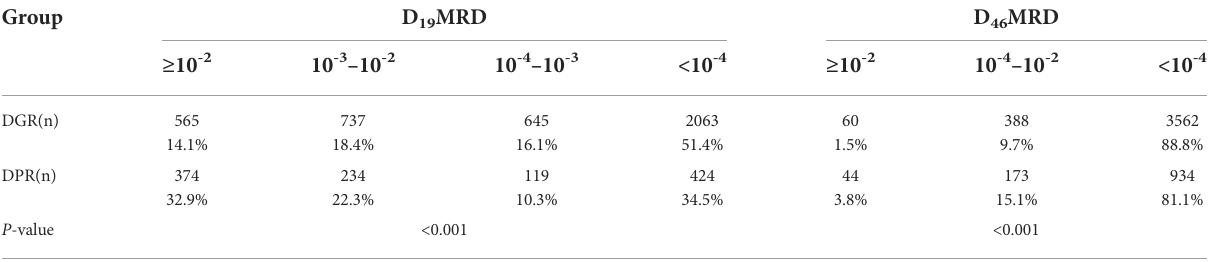
TABLE 3 Minimal residual disease for children with acute lymphoblastic leukemia according to dexamethasone response.